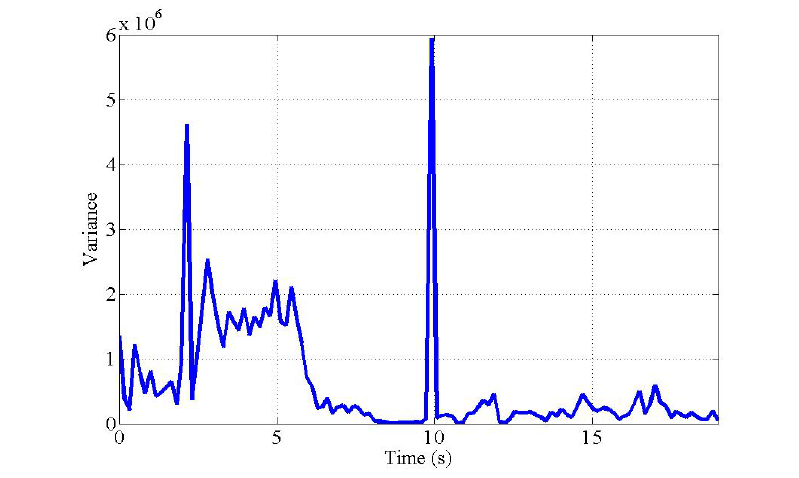
Figure 11. Variance of optical flow